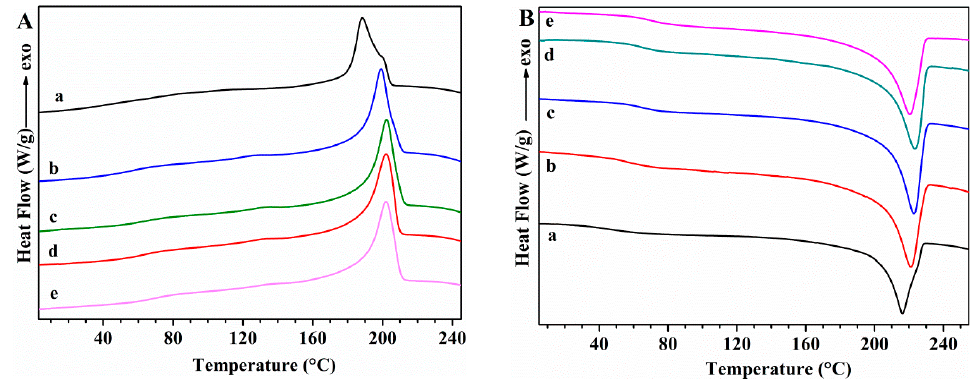
Figure 7. DSC curves: ( A ) first cooling; ( B ) second heating for (a) PVA/GLY; (b) PVA/GS0.5/GLY; (c) PVA/GS1/GLY; (d) PVA/GS1.5/GLY; and (e) PVA/GS2/GLY. Table 1. DSC data for unplasticized and plasticized PVA and PVA/GS nanocomposites. Sample